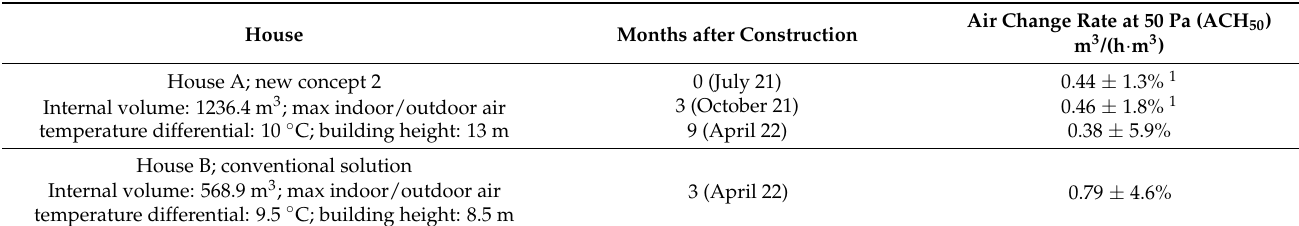
Table 4. Air leakage rate by fan pressurization through House A and House B.